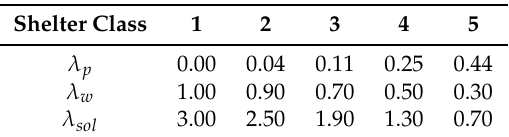
Table 2. Plan area densities λ p [32], wind sheltering factors λ w [3], and solar shielding factors λ sol for five shelter classes: ranging from (1) no shelter to (5) a highly dense urban area (neighboring buildings closer than one building